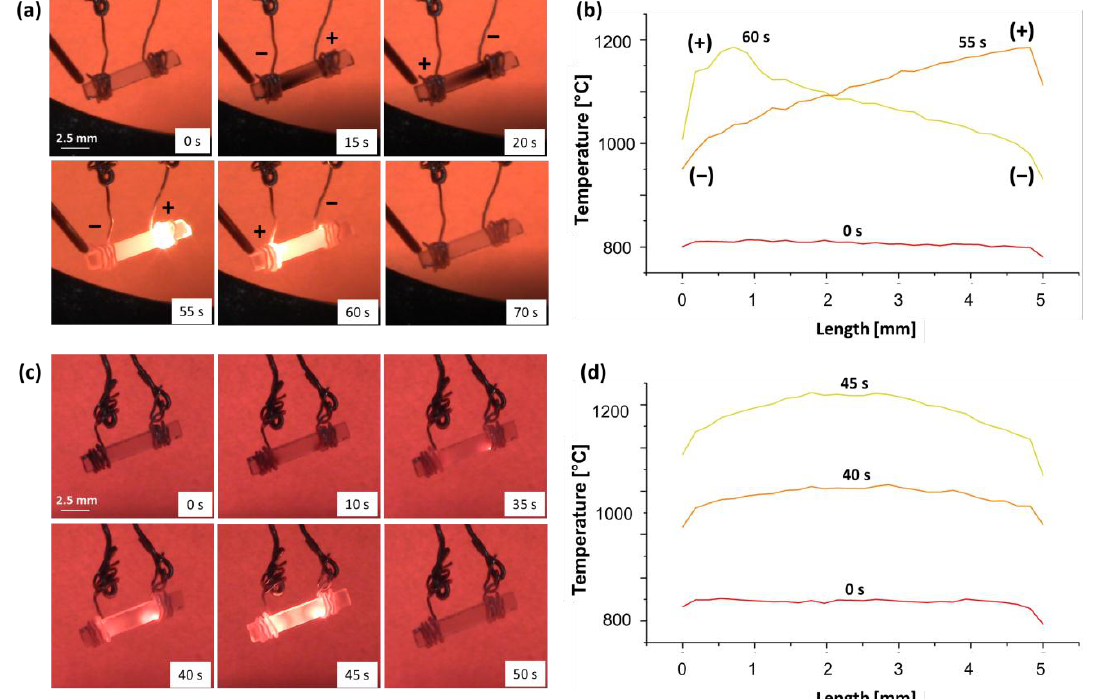
Figure 5. ( a ) Pictures taken with the IR thermo-camera during DC (ΔV lim = 50 V; I lim = 650 mA) FS experiment in “good contact” configuration and corresponding temperature profile along the samples ( b ); the evolution of voltage and current together with the different environment are shown in ( c ). The experiments were carried out with 8YSZ polycrystalline sample (cross section ≈ 2.7 mm 2 ).